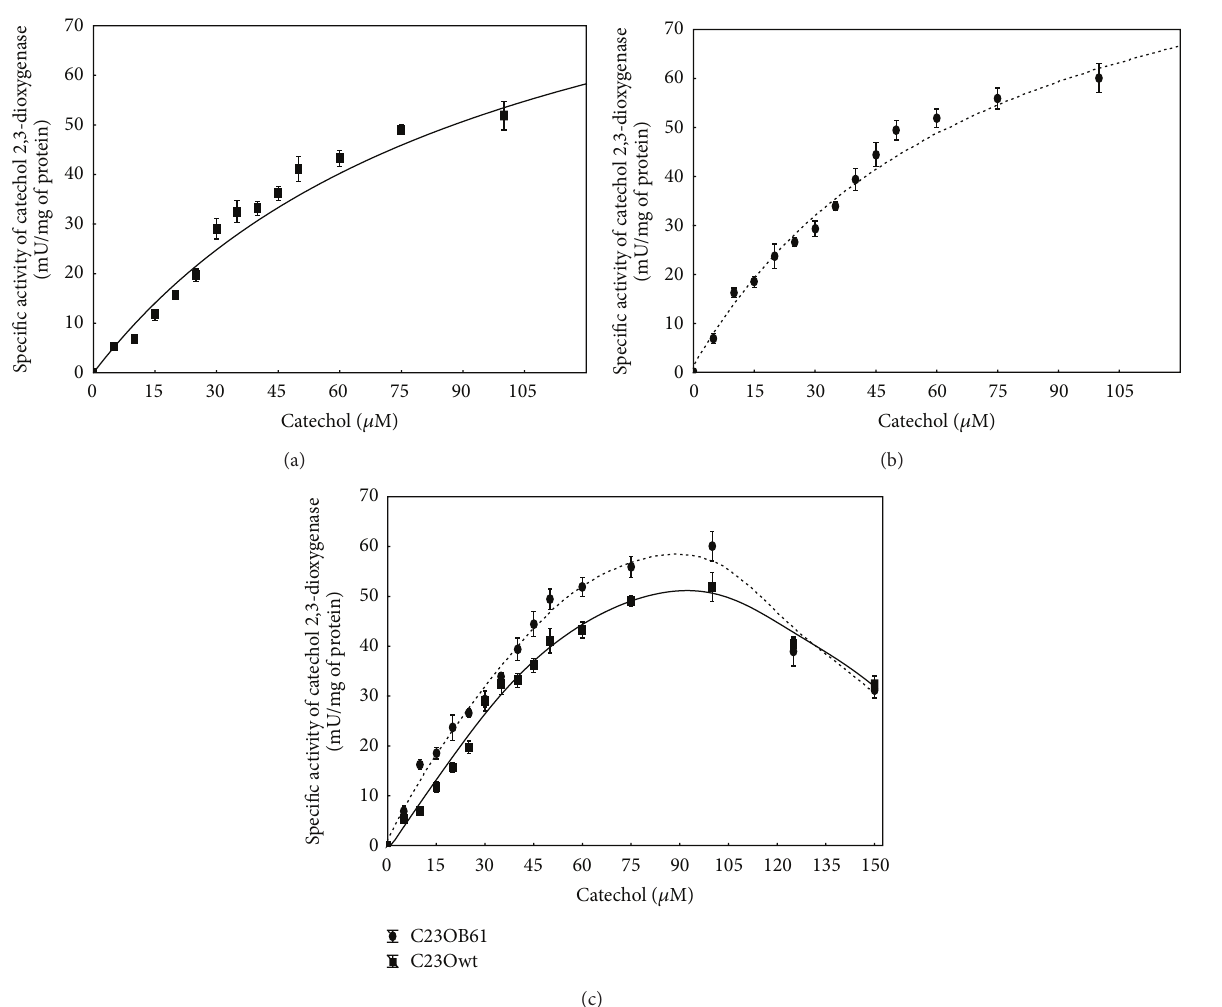
Figure 3: Effects of substrate concentration on the activity of wild-type ((a), (c)) and mutant C23OB61 ((b), (c)) protein. The data points represent the mean ± SD of four experimental replicates. Table 3: Kinetic parameters for catechol oxygenation to 2-hydroxymuconic semialdehyde by wild-type (wt) and mutant C23O dioxygenases. C23Owt C23OB61 Enzyme/substrate 𝜇 M) 𝑉 𝐾 𝜇 M) 𝑉 𝐾 𝑚 ( max (mU/mg) 𝑚 ( max (mU/mg) Catechol 97.74 ± 10.91 115.38 ± 14.40 66.17 ± 9.44 104.50 ± 8.43 All data shown were expressed as mean ± standard deviation ( 𝑛 = 4